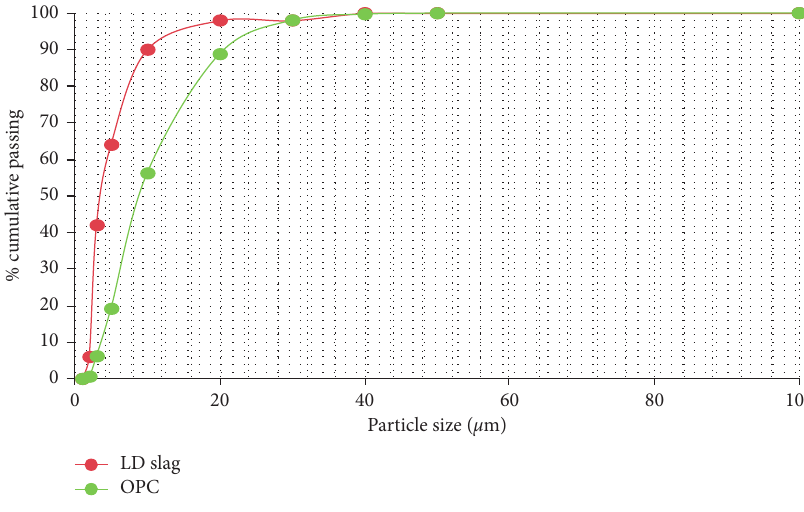
Figure 2: Particle size distribution of OPC and LD slag. Table 2: Concrete mix proportions in kg/m 3 .